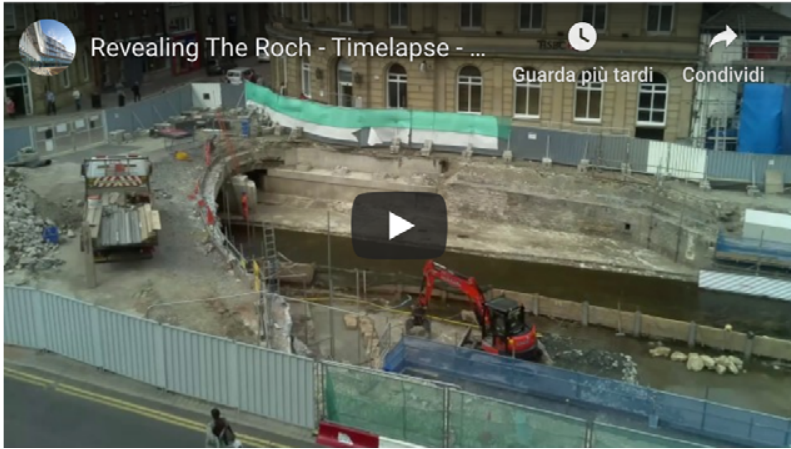
Roch river daylighting timelapse https://youtu.be/x2AQkEG3O8Y FIG.